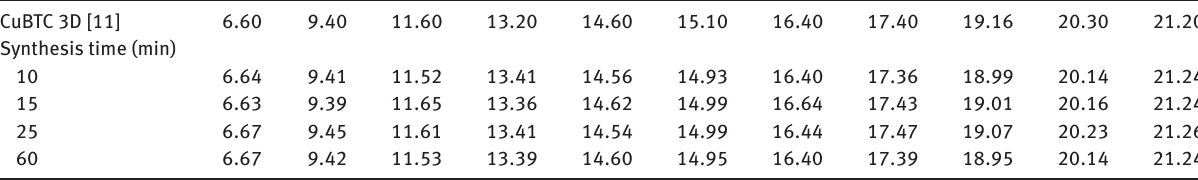
Table 4: 2 θ values of Cu-BTC, formed from Cu and benzene-1,3,5-tricarboxylic acid, synthesized with different times. CuBTC 3D [11]